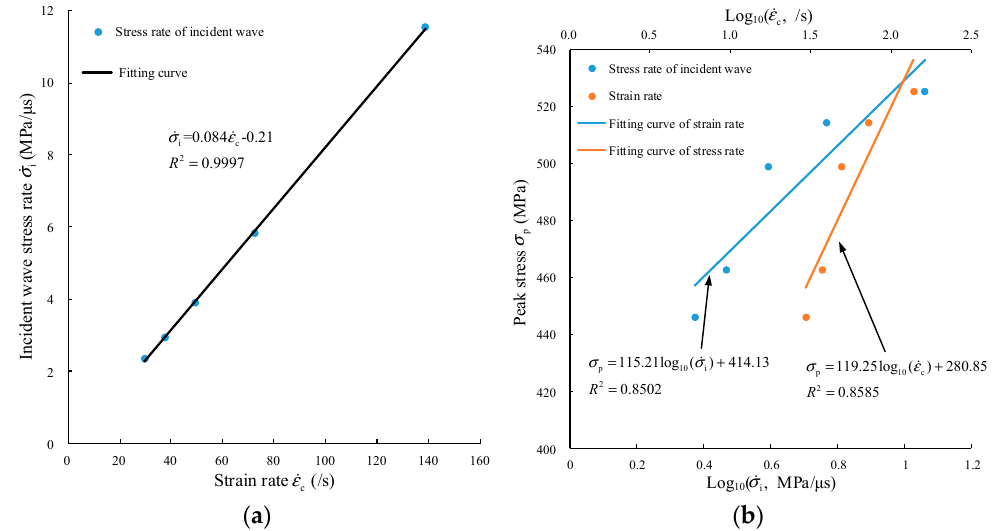
Figure 8. Fitting relationship between the incident wave stress rate and strain rate and peak stress. ( a ) Relationship between stress rate and strain rate; ( b ) relationship between peak stress and stress rate and strain rate.